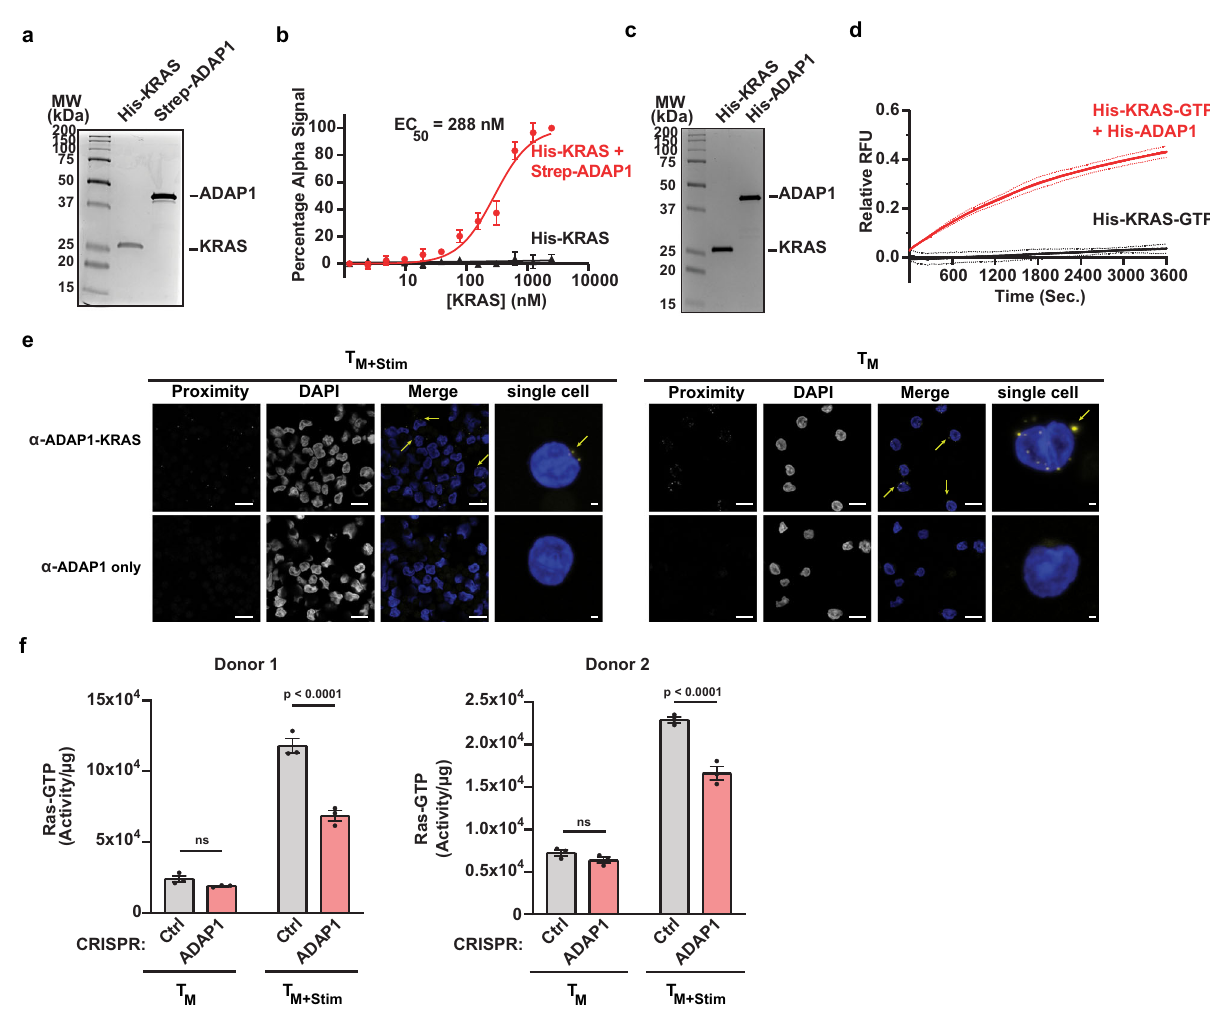
Fig. 7 ADAP1 interacts with and stimulates KRAS GTP hydrolysis. a Coomassie staining of recombinant proteins used in Alpha. b Alpha con fi rms binding of recombinant ADAP1 and KRAS. Data represents mean ± s.d. percent ( n = 3 independent experiments in triplicate). c Coomassie staining of recombinant proteins used in GTPase hydrolysis assay. d GTP-hydrolysis assay con fi rms that ADAP1 stimulates the rate of KRAS GTP hydrolysis ( n = 3). One-phase association fi tted to data to calculate K obs hydrolysis rates. Data represents mean ± s.d. Relative RDU ( n = 3 independent experiments in triplicate). e Proximity ligation assay of unstimulated and stimulated (1 h anti-TCR/anti-CD28 beads) primary T M . Proteins were tested for proximity by incubating cells with ADAP1 and KRAS antibodies. As a negative control for non-speci fi c probe ligation or ampli fi cation, samples incubated with only one antibody were included. Yellow arrows pointing to yellow puncta indicate proteins are in proximity (distances < 40 nm). Images are representative of two donors. Scale bar is 10 μ m for multicell images and 1 μ m for single cell images. f RAS GTP levels in primary ADAP1 CRISPR (red) and Ctrl CRISPR (gray) T M in the absence or presence of anti-TCR/anti-CD28 bead stimulation (10 min). Each graph is a representative donor. Data represents mean ± s.e.m. of Ras GTP / total protein ( μ g) ( n = 3). (two-way ANOVA followed by Sidak ’ s test for multiple comparison between ADAP1 CRISPR and Ctrl CRISPR groups), ns not signi fi cant. Source data are provided as a Source Data fi in acute myeloid leukemia cell lines (e.g., Jurkat, K562) (Fig. 1g and https://www.proteinatlas.org/ENSG00000105963-ADAP1/